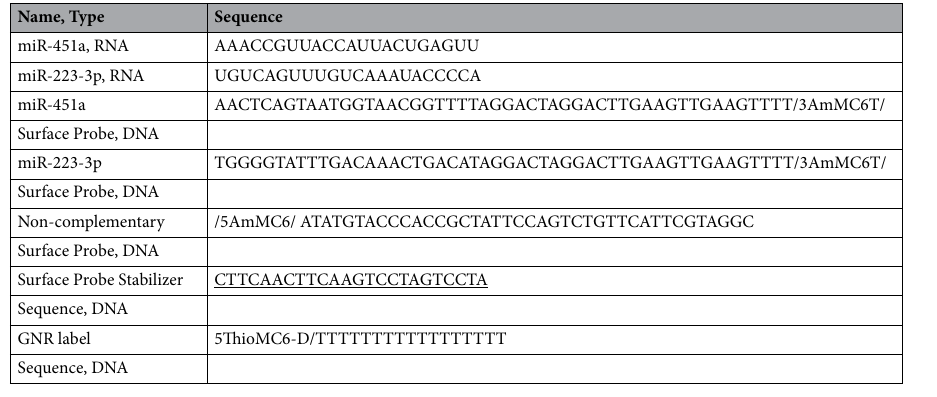
Table 1. Sequences for miRNAs and their complementary surface